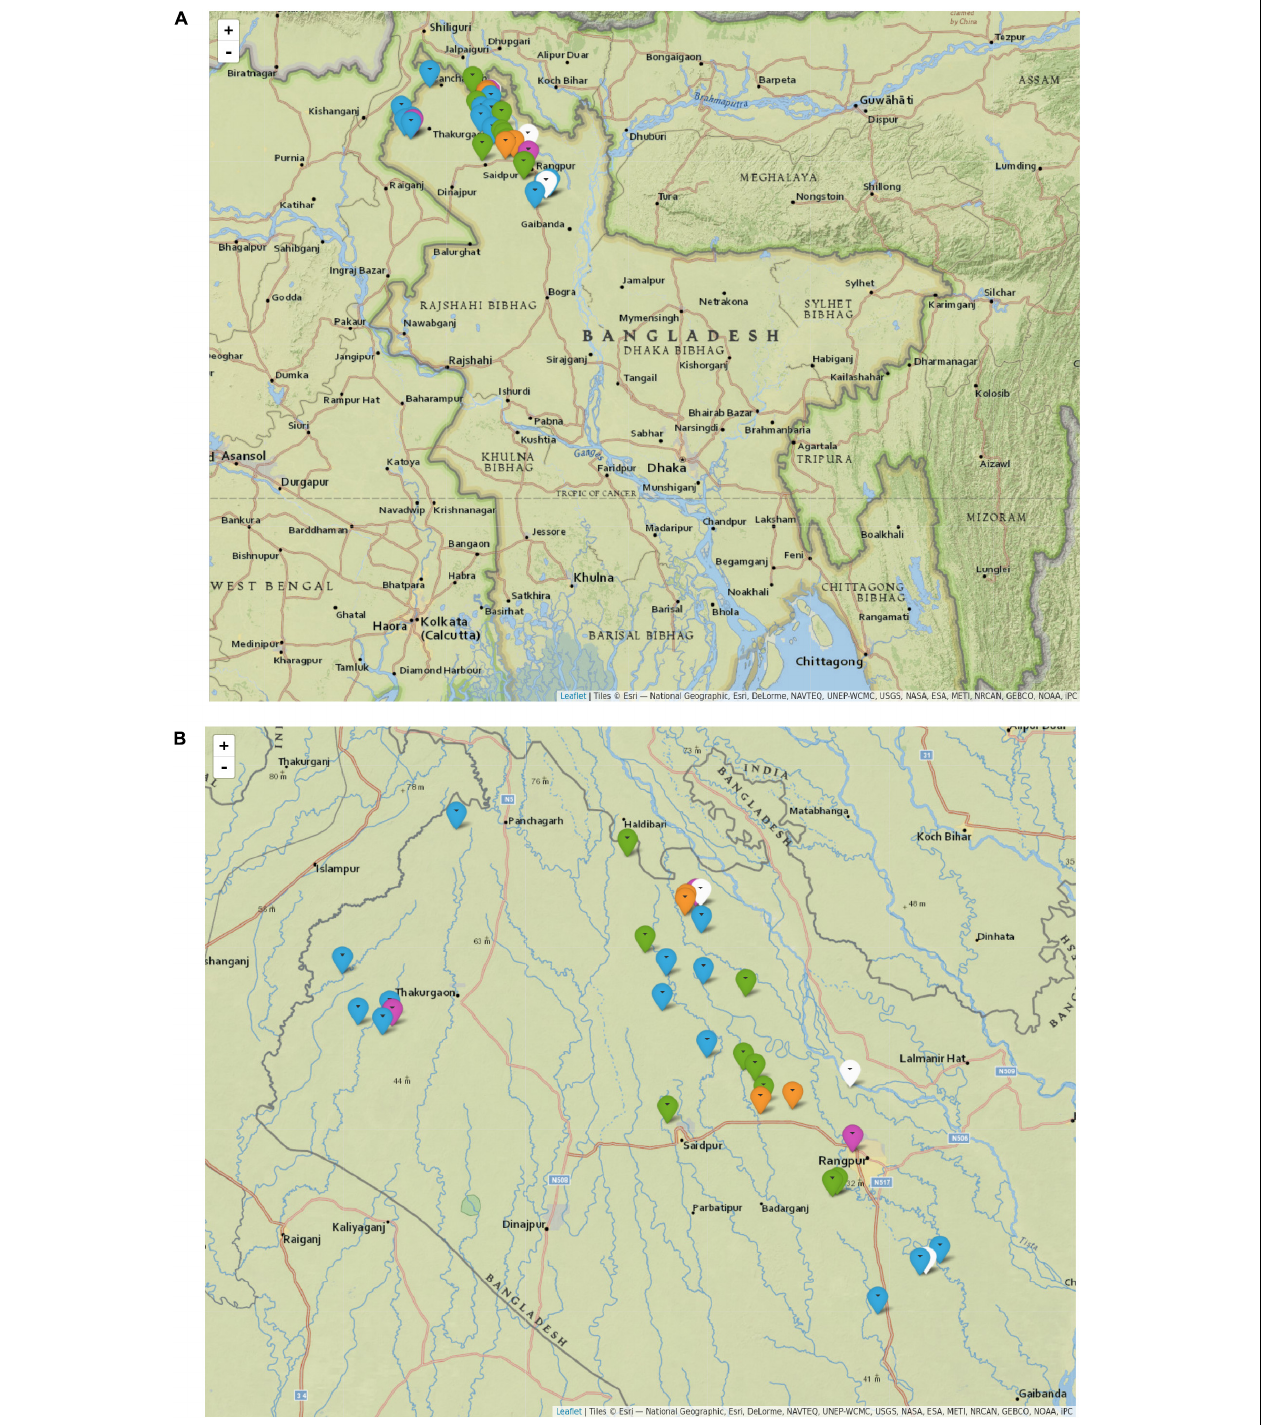
FIGURE 3 | Distribution of M. leprae genotypes in Bangladesh. Map of Bangladesh including markers indicating the residence of every subject with at least one sample genotyped for M. leprae (A) , and zoomed into the area of interest (B) . Each marker indicates an individual for whom M. leprae genotype was determined, either from slit skin smear, nasal swab or both samples. Genotype 1A is shown in green, 1B-Bangladesh in orange, 1D in blue, 1D- esxA in purple and 1* in white. 1D- esxA is 1D subtype containing an A at SNP61425 in the esxA gene, formerly grouped as 1C (Monot et al., 2009; Truman et al., 2011). 1* are samples with genotype 1 for which the subtype could not be determined. The figure was drawn in R (v3.4.3) with the package leaflet (v2.0.2) using maps from Esri – National Geographic with permission. Scale Not Given. “National Geographic World Map.” December 13, 2011. http://www.arcgis.com/home/item.html?id=b9b1b422198944fbbd5250b3241691b6 (September 2,